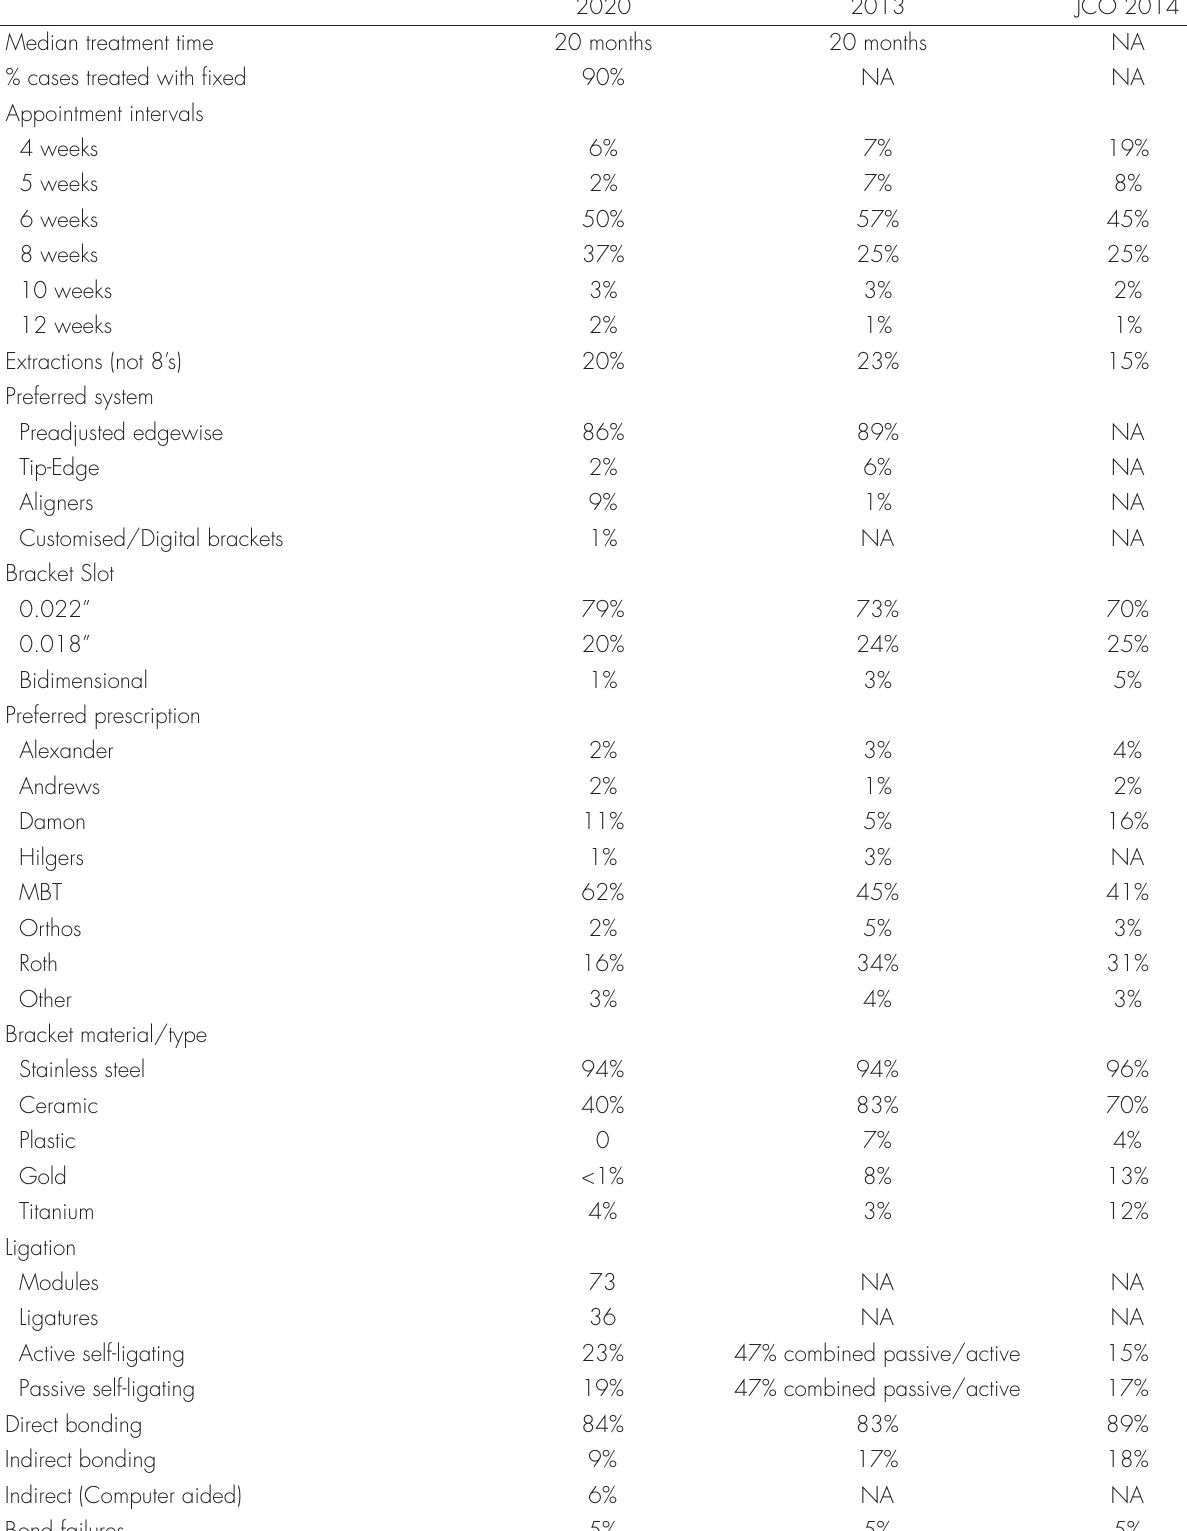
Table IV. Comprehensive fixed appliance